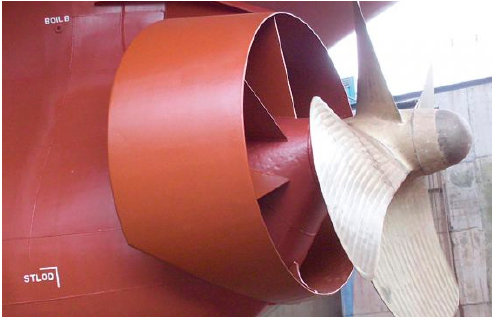
Figure 3. Photograph of an installed full ‐ scale Mewis Duct [23].